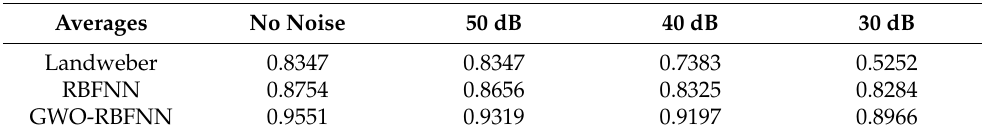
Table 2. Average RMSE with noise test set.